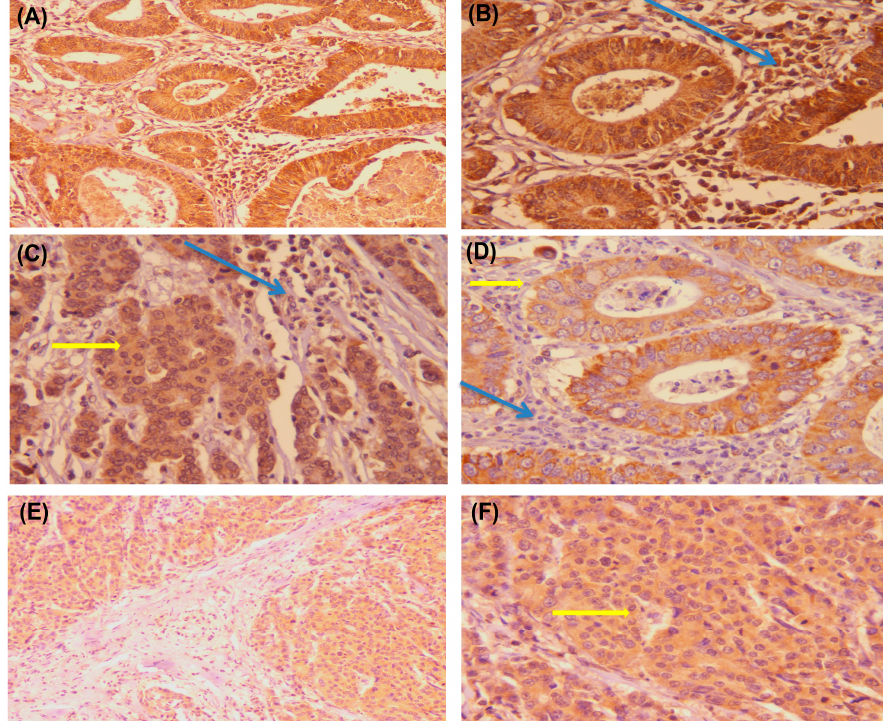
Figure 4. Immunohistochemical staining of colonic adenocarcinoma for PDL1. Positive expressions of PDL1 on tumor cells (yellow arrow) and intertumoral lymphocytes in G1 colonic adenocarcinoma (blue arrow) were observed (( A ) × 200 and ( B ) × 400). G2 adenocarcinoma showed moderate expres- sion of PDL1 on intratumor immune cells (blue arrow) and tumor cells (yellow arrow) ( C ) × 400). The expression is mainly cytoplasmic; however, in the photo (( D ) × 400), the expression of PDL1 in tumor cells was mainly membranous (yellow arrow) with no expression on intratumor immune cells (blue arrow). In addition, G3 adenocarcinoma showed moderate expression of PDL1 on tumor cells (yellow arrow in panel F) (( E ) × 200 and ( F ) × 400). Regarding PDL1 overexpression in NC and IIC association with the clinicopatholog- ical characteristics, using a two-sided Chi-square test, there were significant associations with the advanced lymph node stage ( p = 0.00, 0.000) and advanced Dukes stage ( p = 0.000, 0.000). In addition, PDL1 overexpression in IICs exhibited a significant association with the presence of distant metastasis ( p = 0.01) and shorter OS ( p = 0.01). While PD1 overex- pression in IICs exhibited significant association with T2/T3 ( p = 0.002), N0 ( p = 0.00), M0 ( p = 0.00), early Dukes stage ( p = 0.00), and absence of relapse ( p = 0.00) (Table 3). 3.4. Combined Expression Patterns of PDL1 in Neoplastic and Infiltrating Immune Cells, and Association with the Clinicopathological Prognostic Factors of Colon Adenocarcinomas The combined expression pattern of PDL1 includes four groups. Group A (NC-/IIC- ), Group B (NC+/IIC-), Group C (NC-/IIC+), and Group D (NC+/IIC+). The studied cases